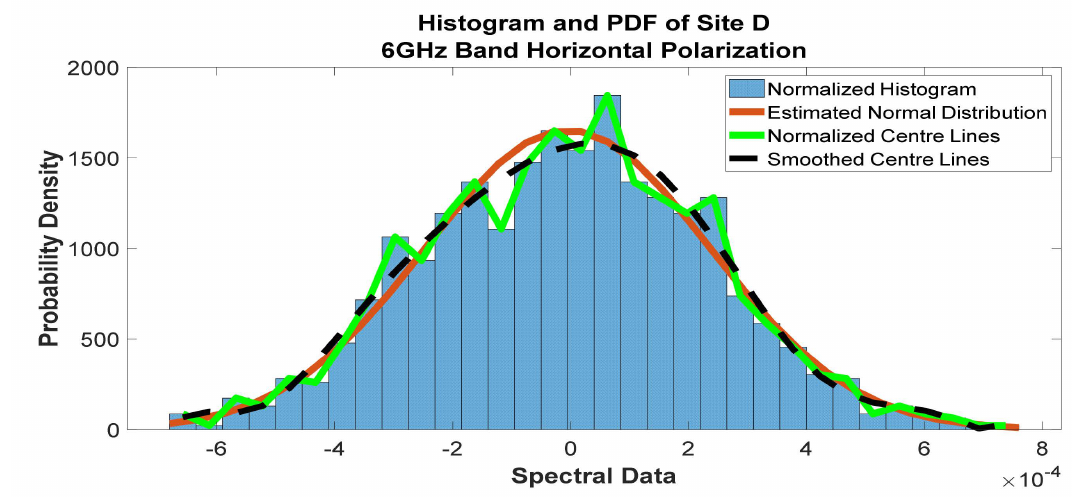
Figure 14. Histogram and PDF of the frequency scan for site D at 6 GHz horizontal polarization.